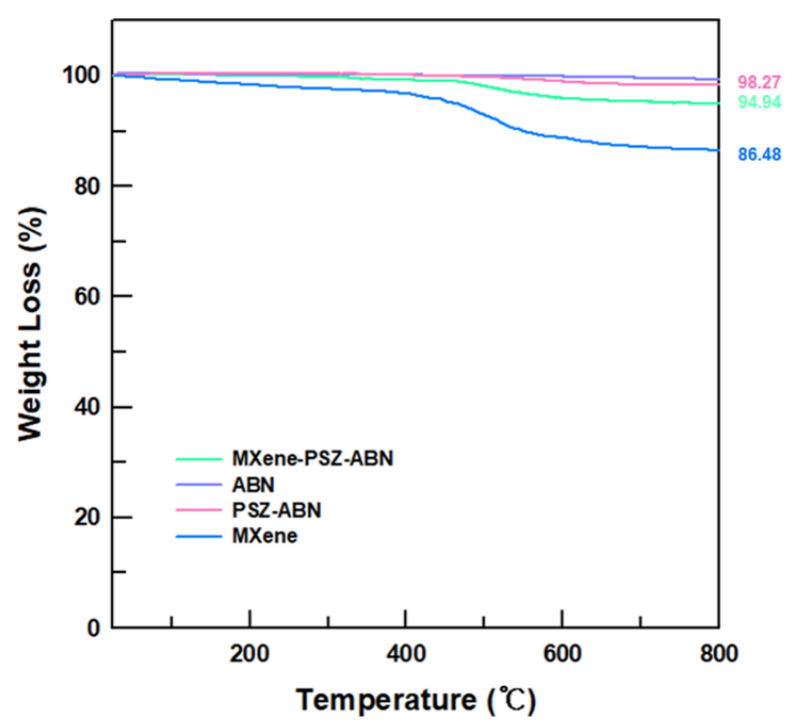
Figure 4. TGA curves of the raw ABN, the raw MXene, the PSZ-ABN, and the MXene-PSZ-ABN.